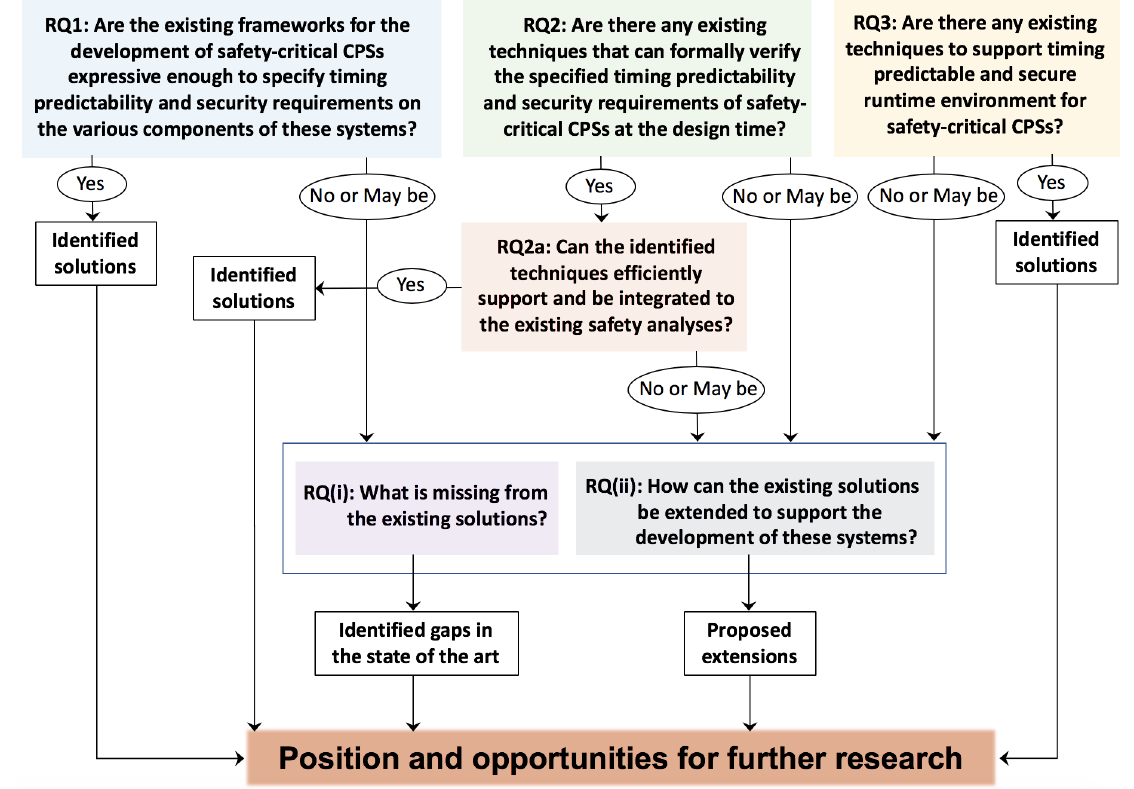
Figure 2. Research questions and expected outcomes contributing to the position and identification of opportunities for further